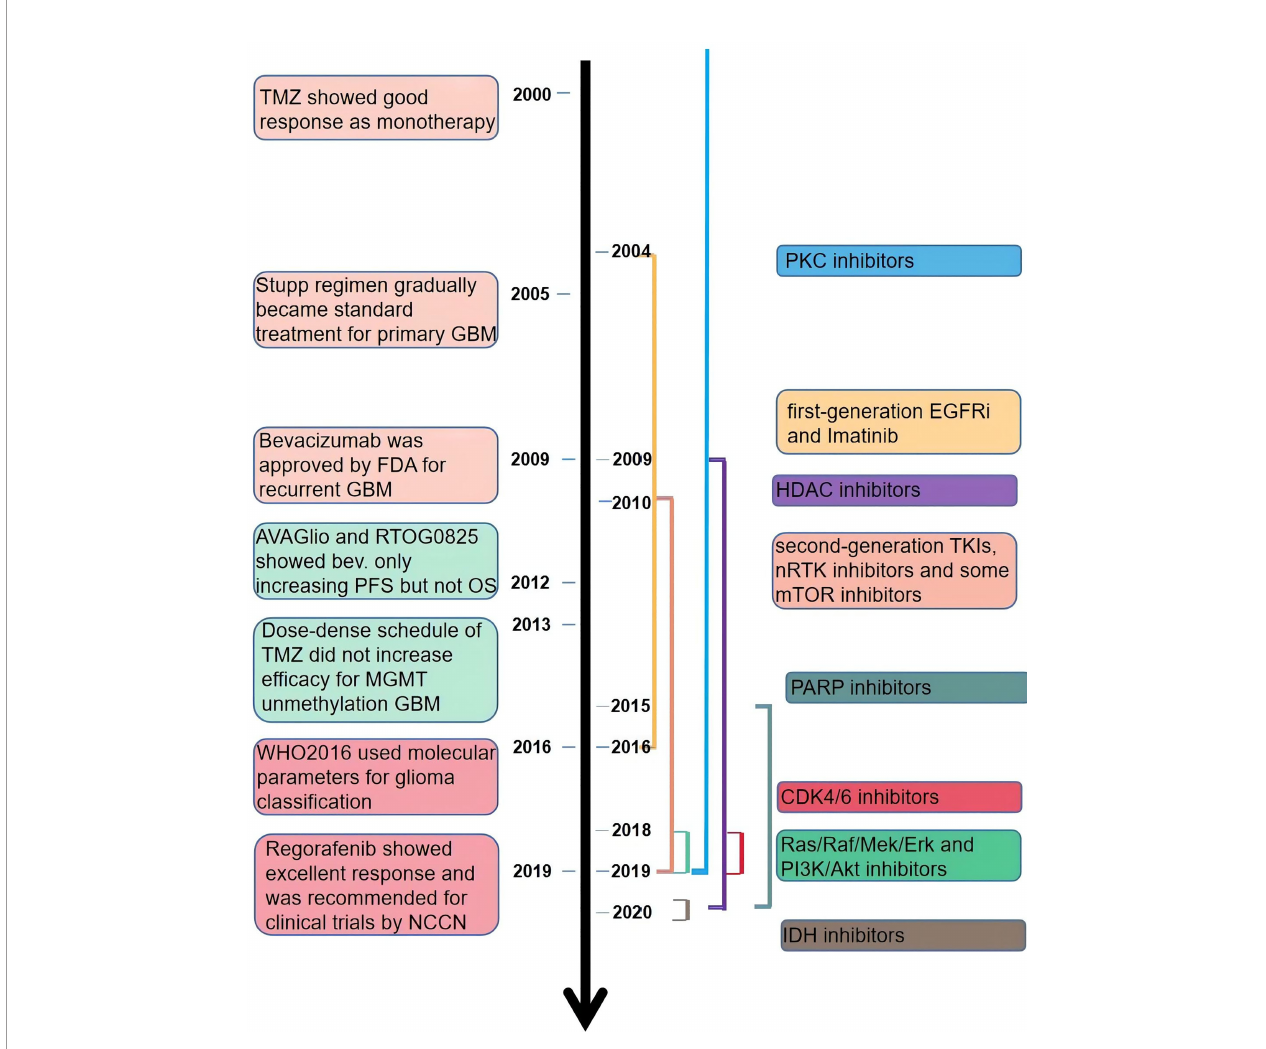
FIGURE 2 | The time line of publicly published clinical trials of the small-molecule